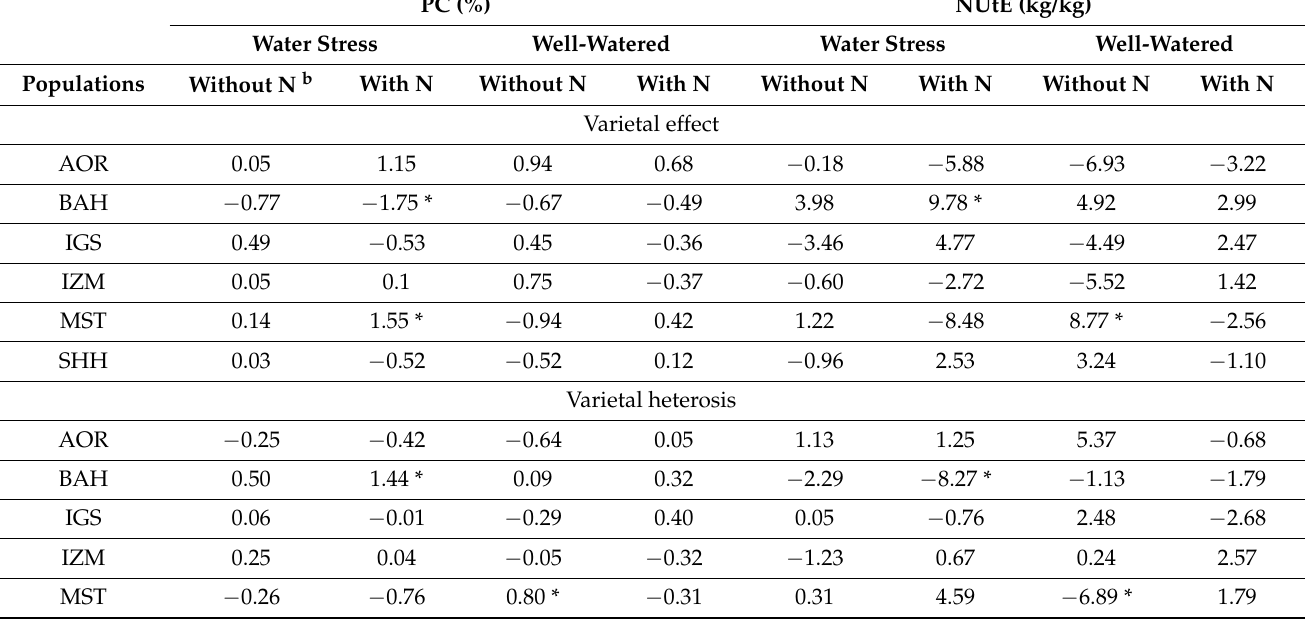
Table 10. Genetic parameters for grain protein content (PC) and nutrient utilization efficiency (NUtE) from the analyses of Gardner and Eberhart [61] (1966) (varietal effect, heterosis effect, specific heterosis, and average heterosis) for two traits in the diallel made among six Algerian maize populations evaluated in two years in Algiers under both managed drought and nitrogen